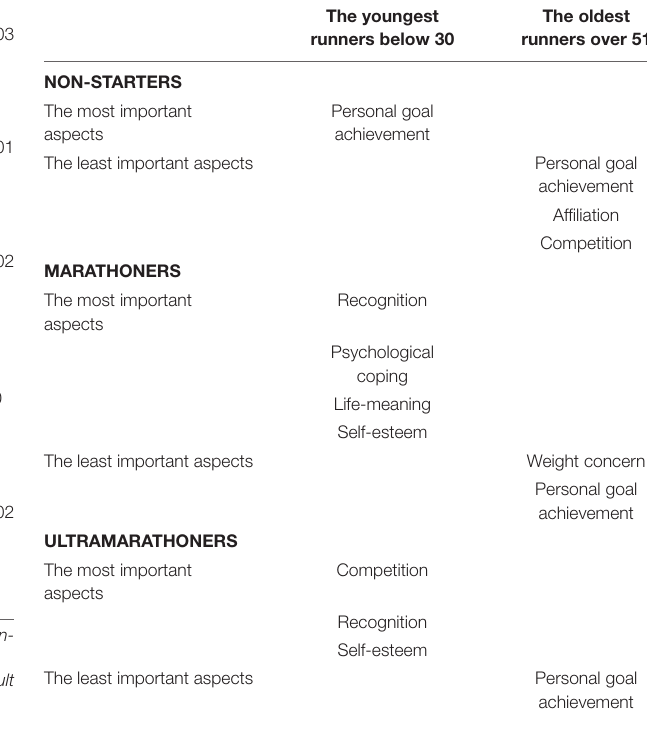
TABLE 5 | The youngest runners vs. the oldest runners (statistically significant